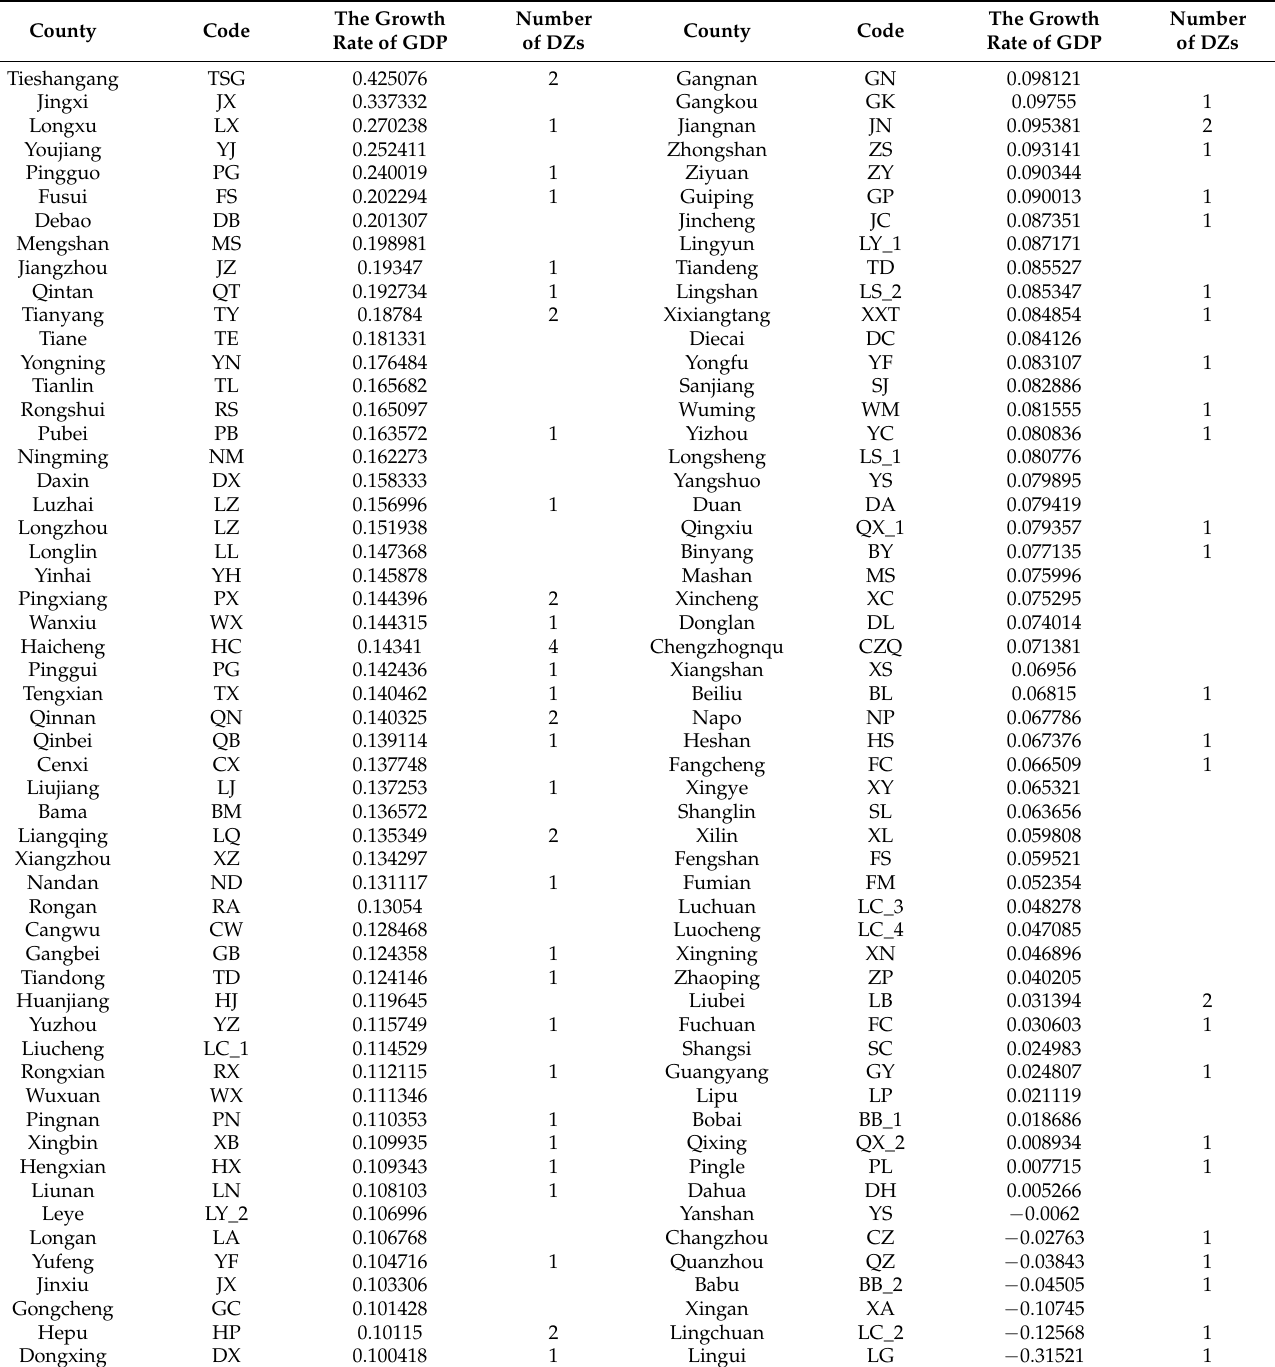
Table A1. The growth rate of GDP and the number of development zones for every county in